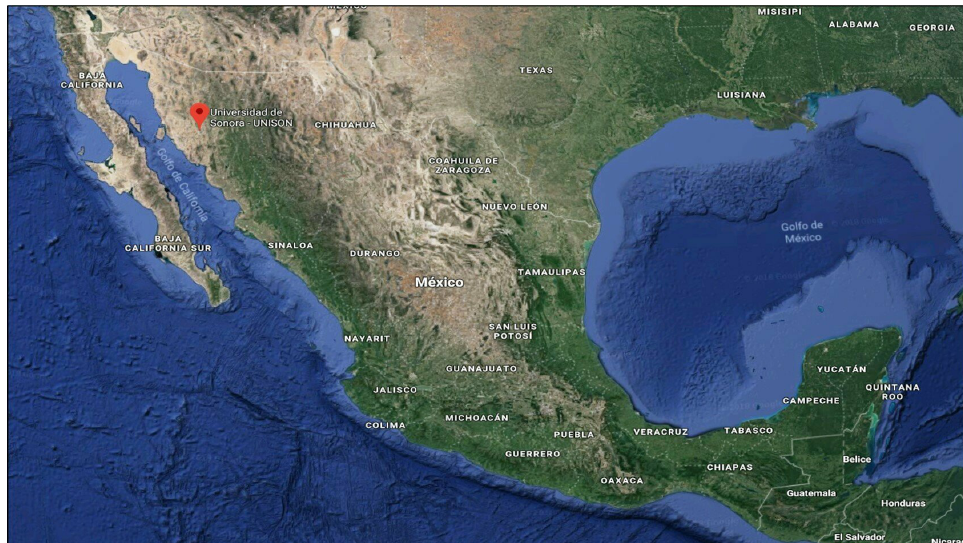
Figure 3. The geographical location of the Hermosillo Site (HS) [49] (29.0843293 N, − 110.9583558 W).